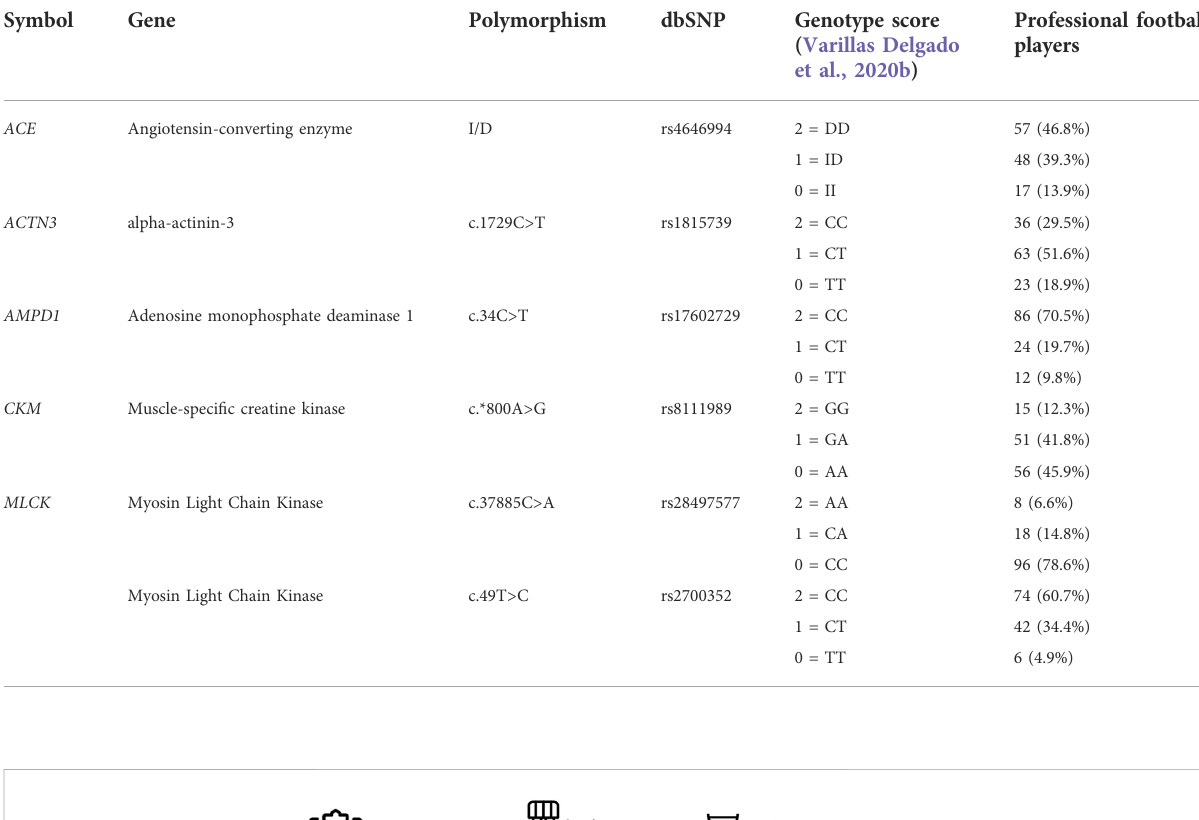
TABLE 3 Genotyping frequency in the professional soccer players.